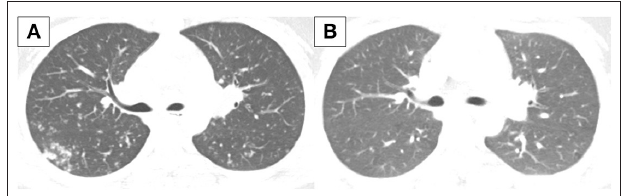
FIGURE 2 | Chest CT conducted (A) at diagnosis of miliary TB and (B) after TB treatment. (A) Innumerable small discrete nodules of random distribution with tree in bud pattern are observed in both lungs. (B) There is a decrease in extent of the innumerable small nodules in both lungs. CT, computed tomography; TB, tuberculosis.